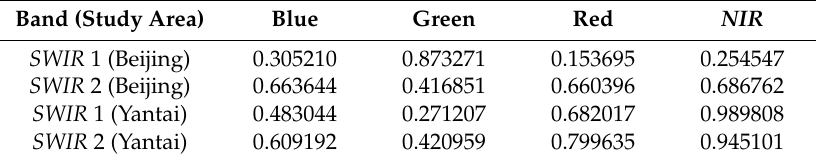
Table 1. Correlation coefficient between RGB/ NIR and SWIR bands in the study